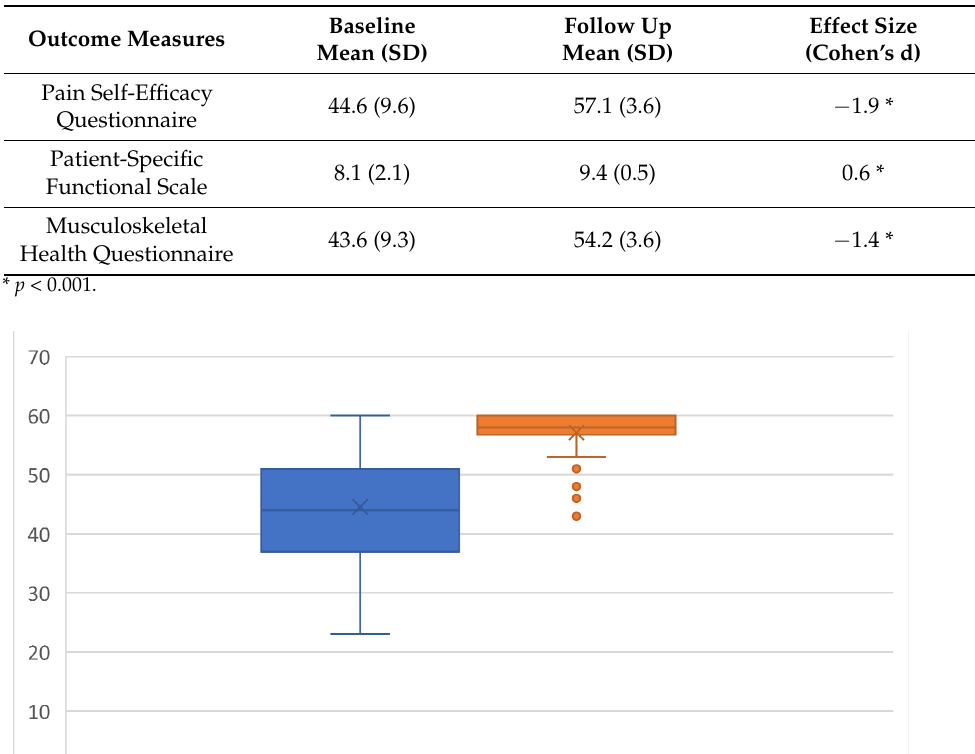
Table 2. Baseline and follow-up outcome measurements.